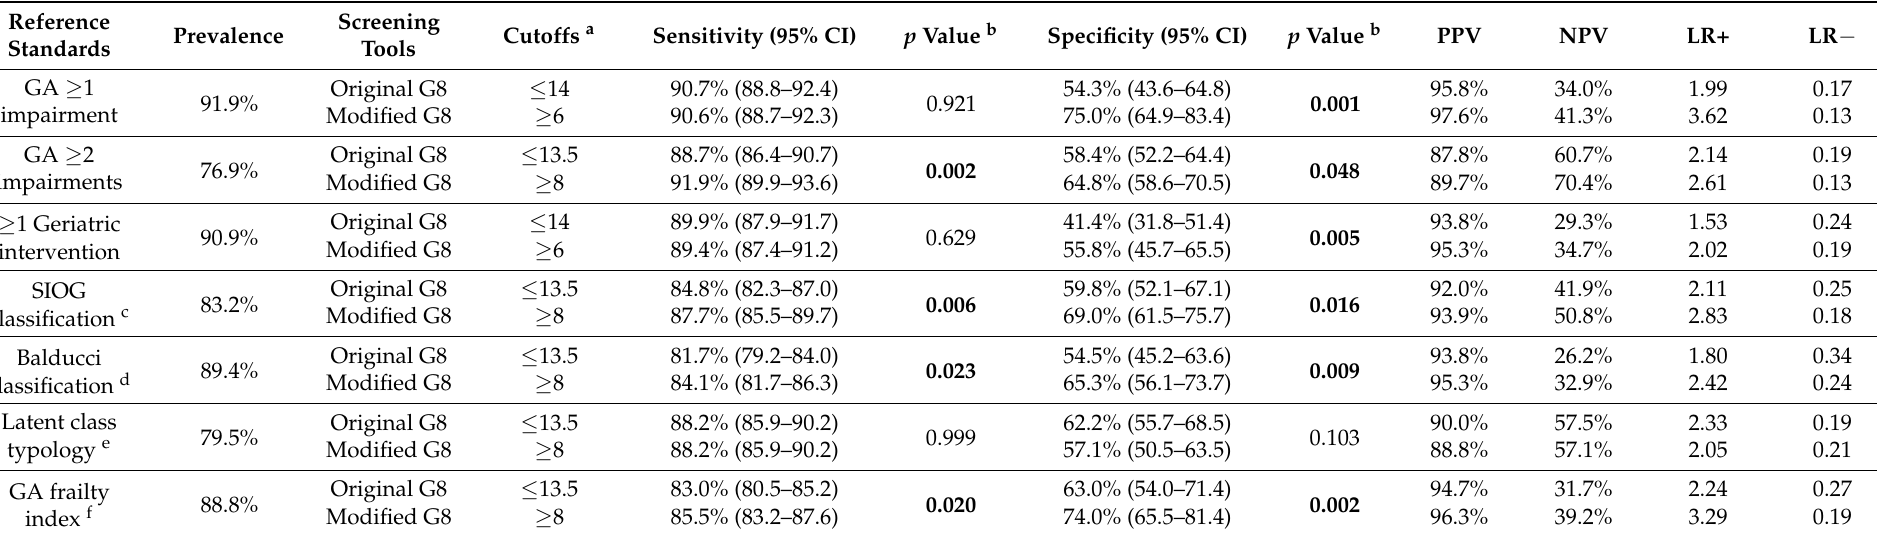
Table 4. Diagnostic performance of G8 and modified G8 according to reference